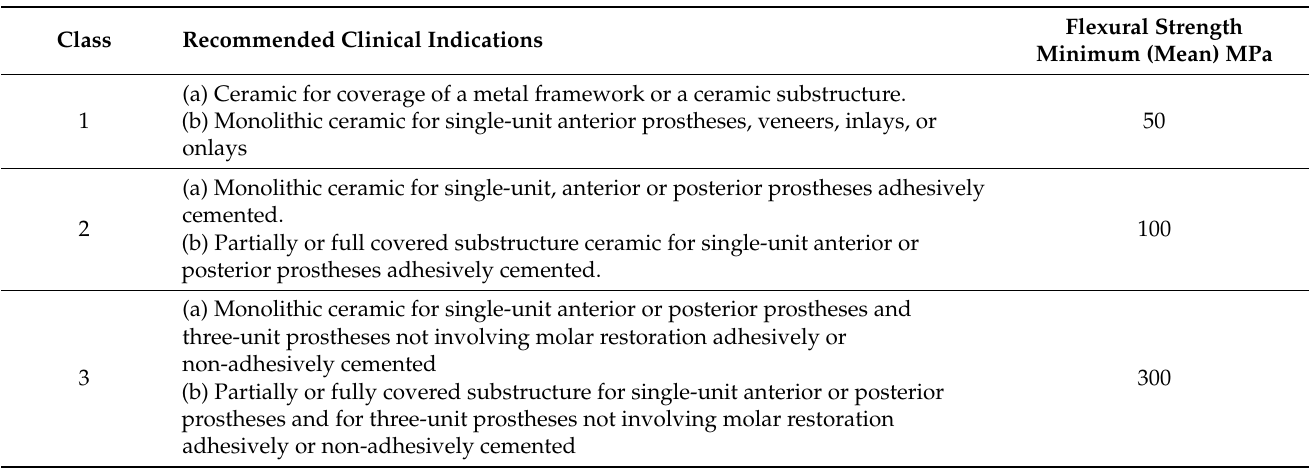
Table 3. Recommended clinical indications of ISO standards 6872:2015 (Classes 1, 2, and 3).